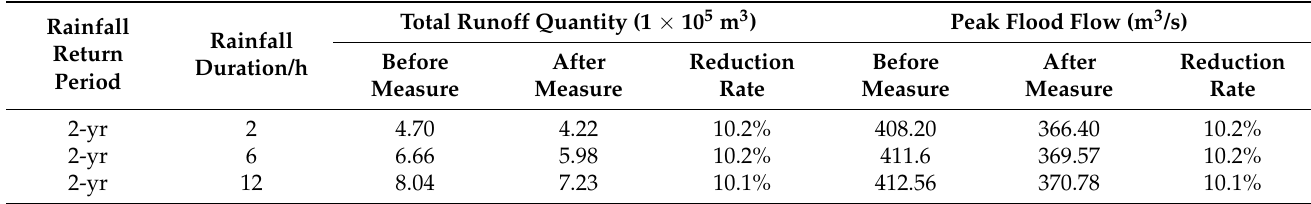
Table 12. Analysis on surface runoff under different rainfall duration.